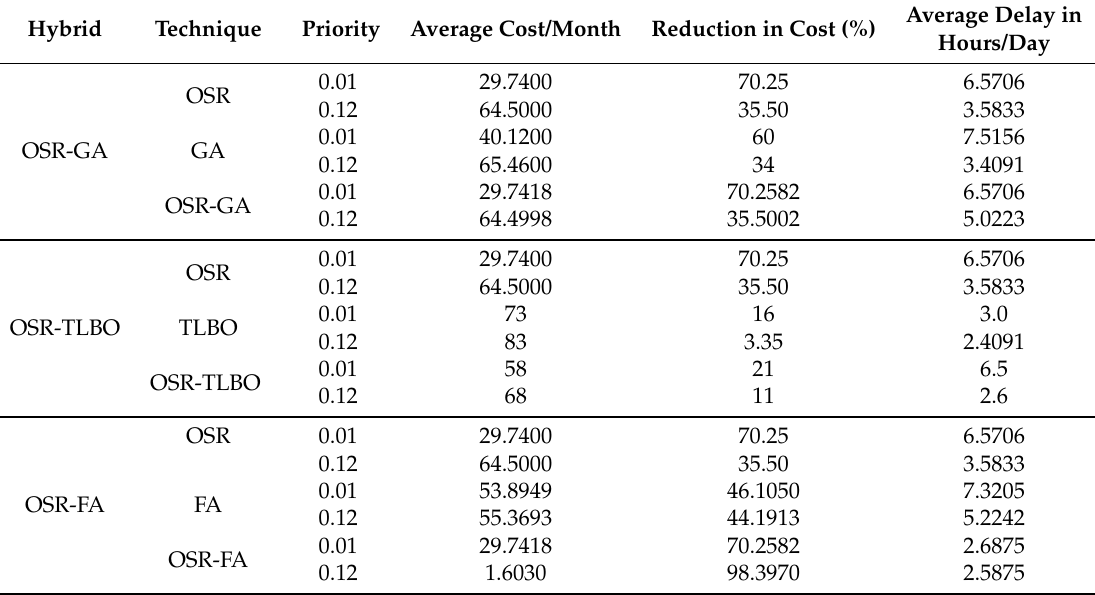
Table 6. Cloth Dryer Simulation